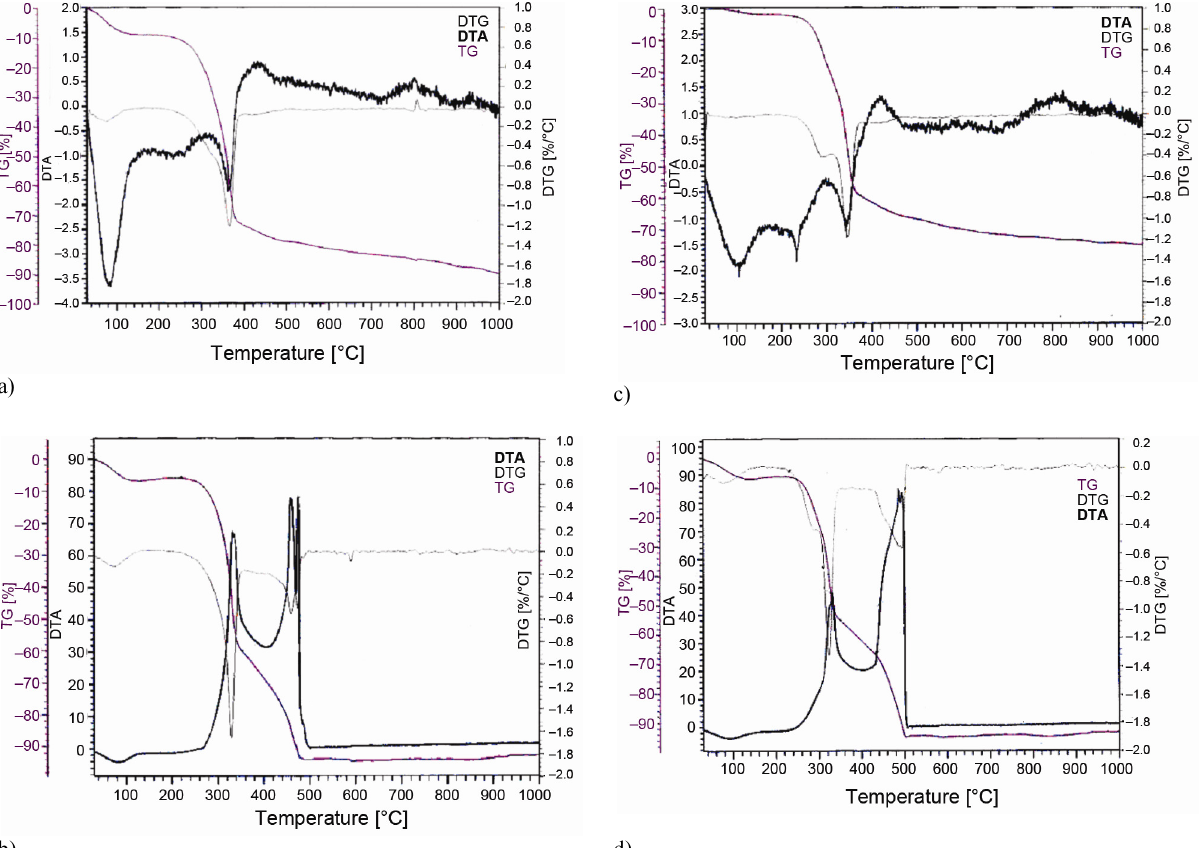
Fig. 15. Curves of thermogravimetric analysis for oak and pine wood (a – pine, nitrogen medium; b – pine, air medium; c – oak, nitrogen medium; d – oak, air